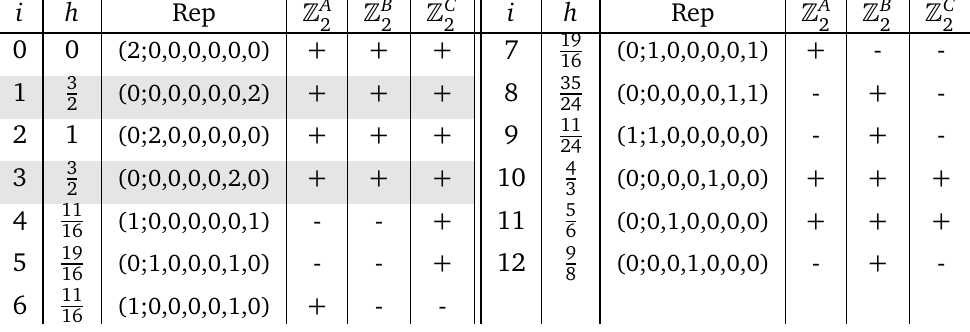
, (cid:90) B , (cid:90) C , 2 2 2 × (cid:90) 2 2